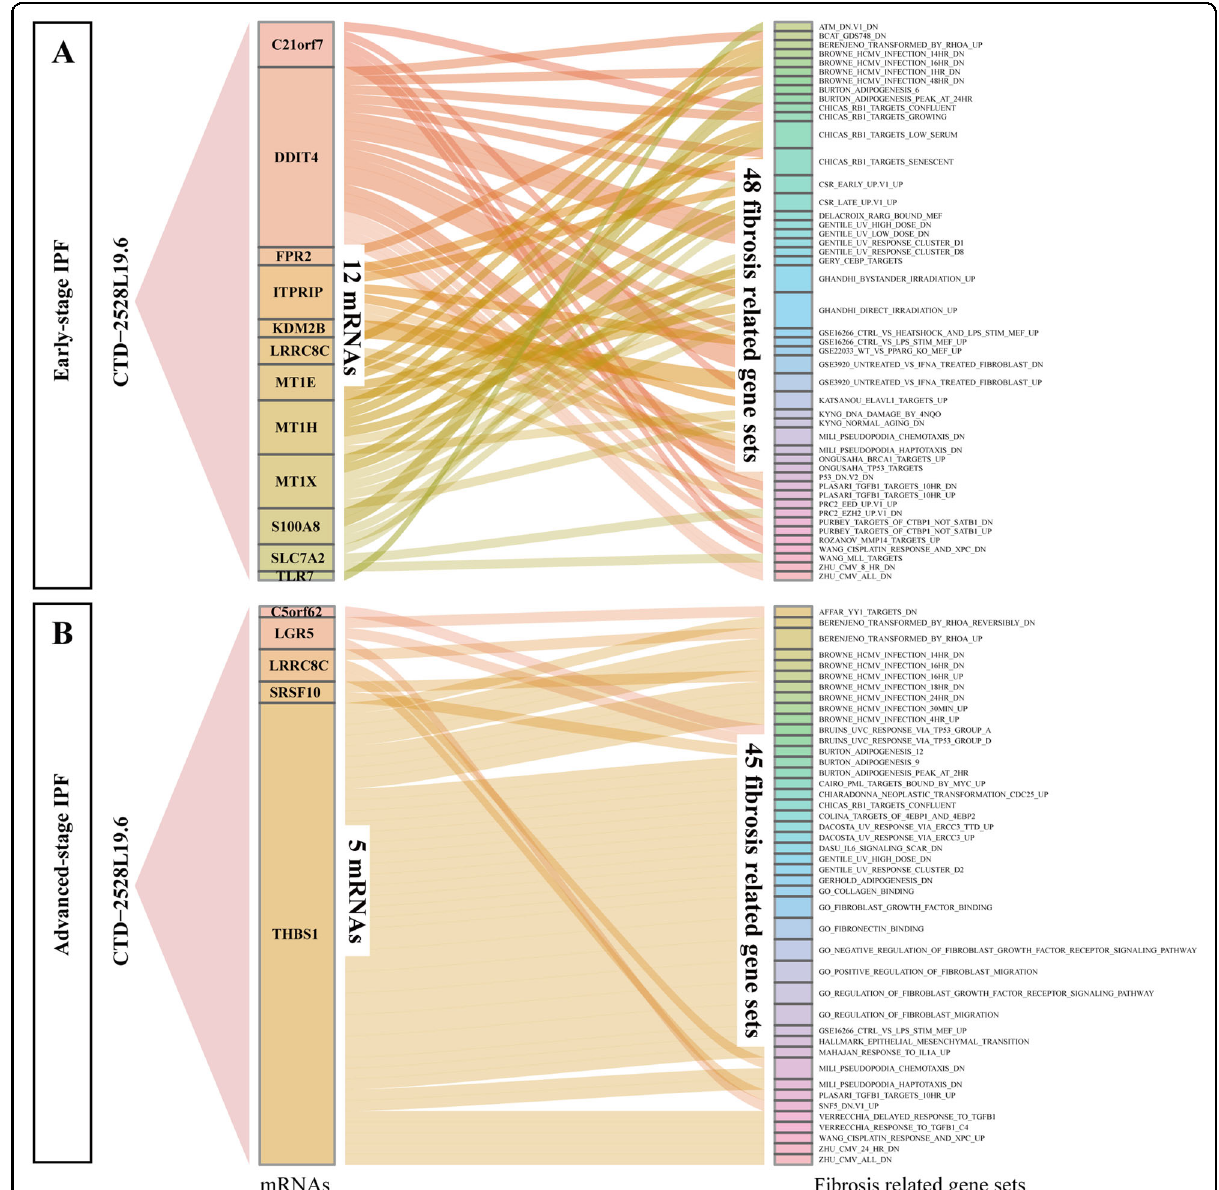
Fig. 4 Illustration of fi brosis related gene sets that contain the mRNAs co-expressed with lncRNAs in the progression of IPF. A, B Sankey diagrams display the connection between CTD-2528L19.6 correlated mRNAs and fi brosis related gene sets in early-stage IPF ( A ) and advanced-stage IPF ( B ). The expression of mRNAs in diagrams are correlated with the expression of CTD-2528L19.6 (|r| >0.8, P < 0.01, P earson Correlation Test). Path connecting an mRNA to a fi brosis related gene set represents the mRNA participates in the gene